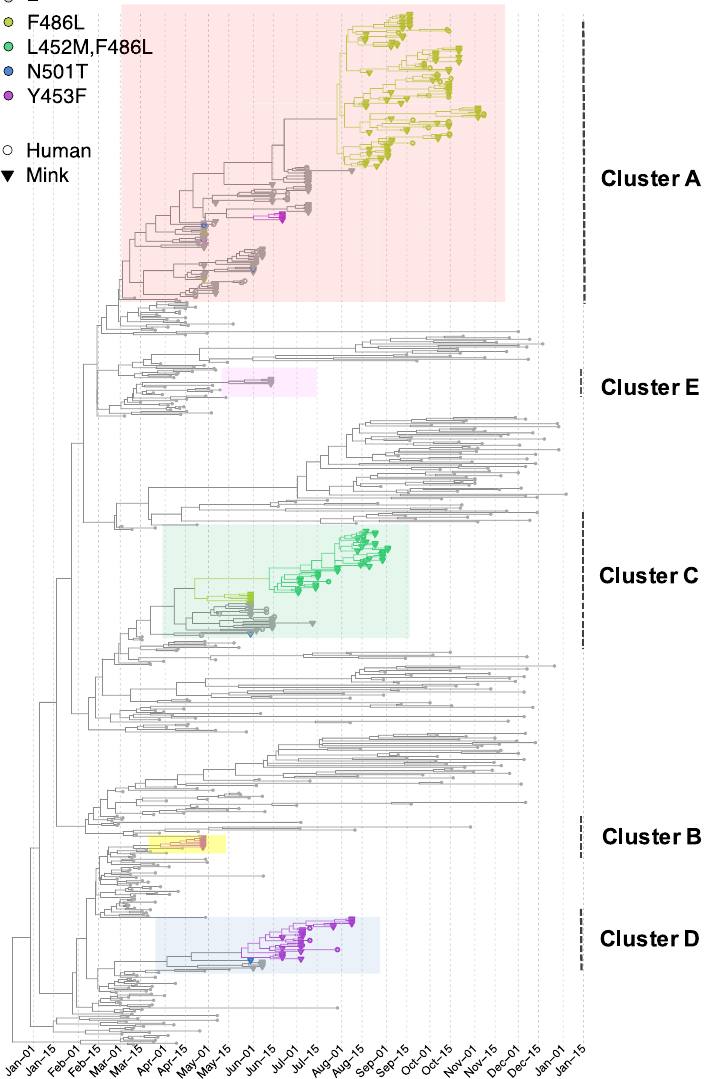
Fig. 2 Time-scaled maximum clade credibility (MCC) tree of SARS-Cov2 sequences mapping with 4 amino acid changes (L452M, Y453F, F486L and N501T) of the spike protein. The phylogeny is the same as Fig. 1c. Tips with speci fi c amino acid changes are enlarged and in different colours; sequences isolated from mink and human are in triangle and circle, respectively. The 5 viral clusters are highlighted on the tree and labelled on